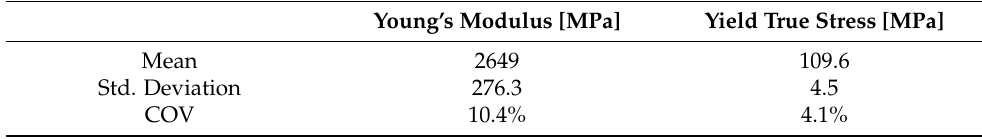
Table 11. Mechanical compression test